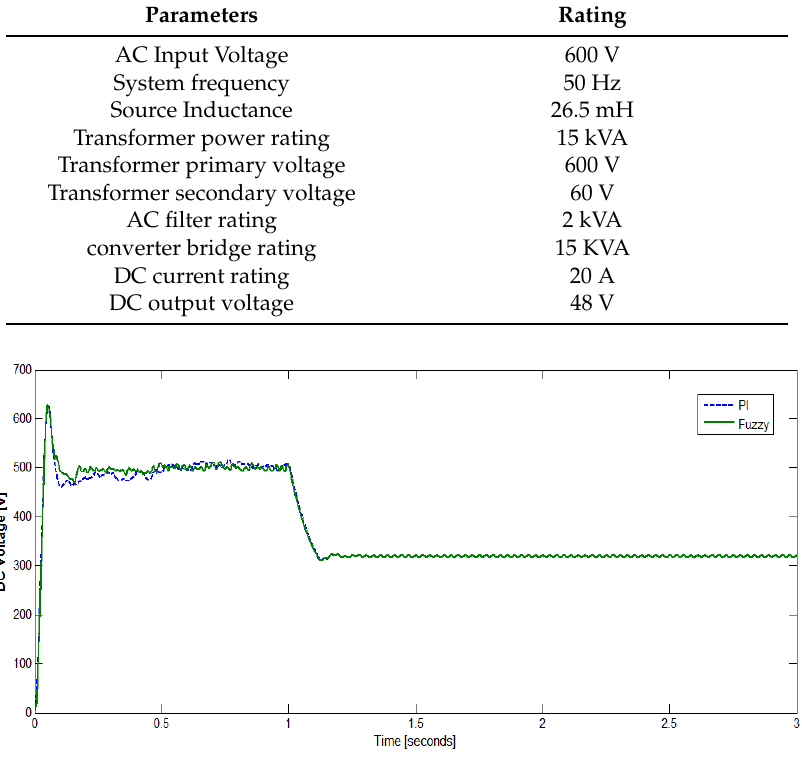
Figure 9. Rectified DC voltage waveform using fuzzy control.